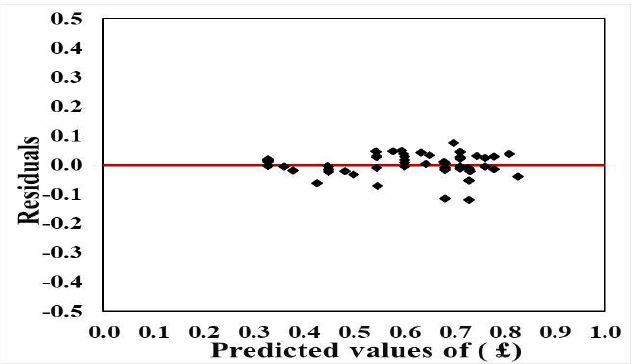
Figure 17. The distribution of residuals around the line of zero error for predicted values of £.